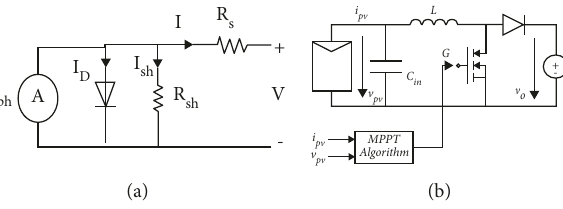
Figure 1: Solar PV basic circuits: (a) solar cell and (b) PV